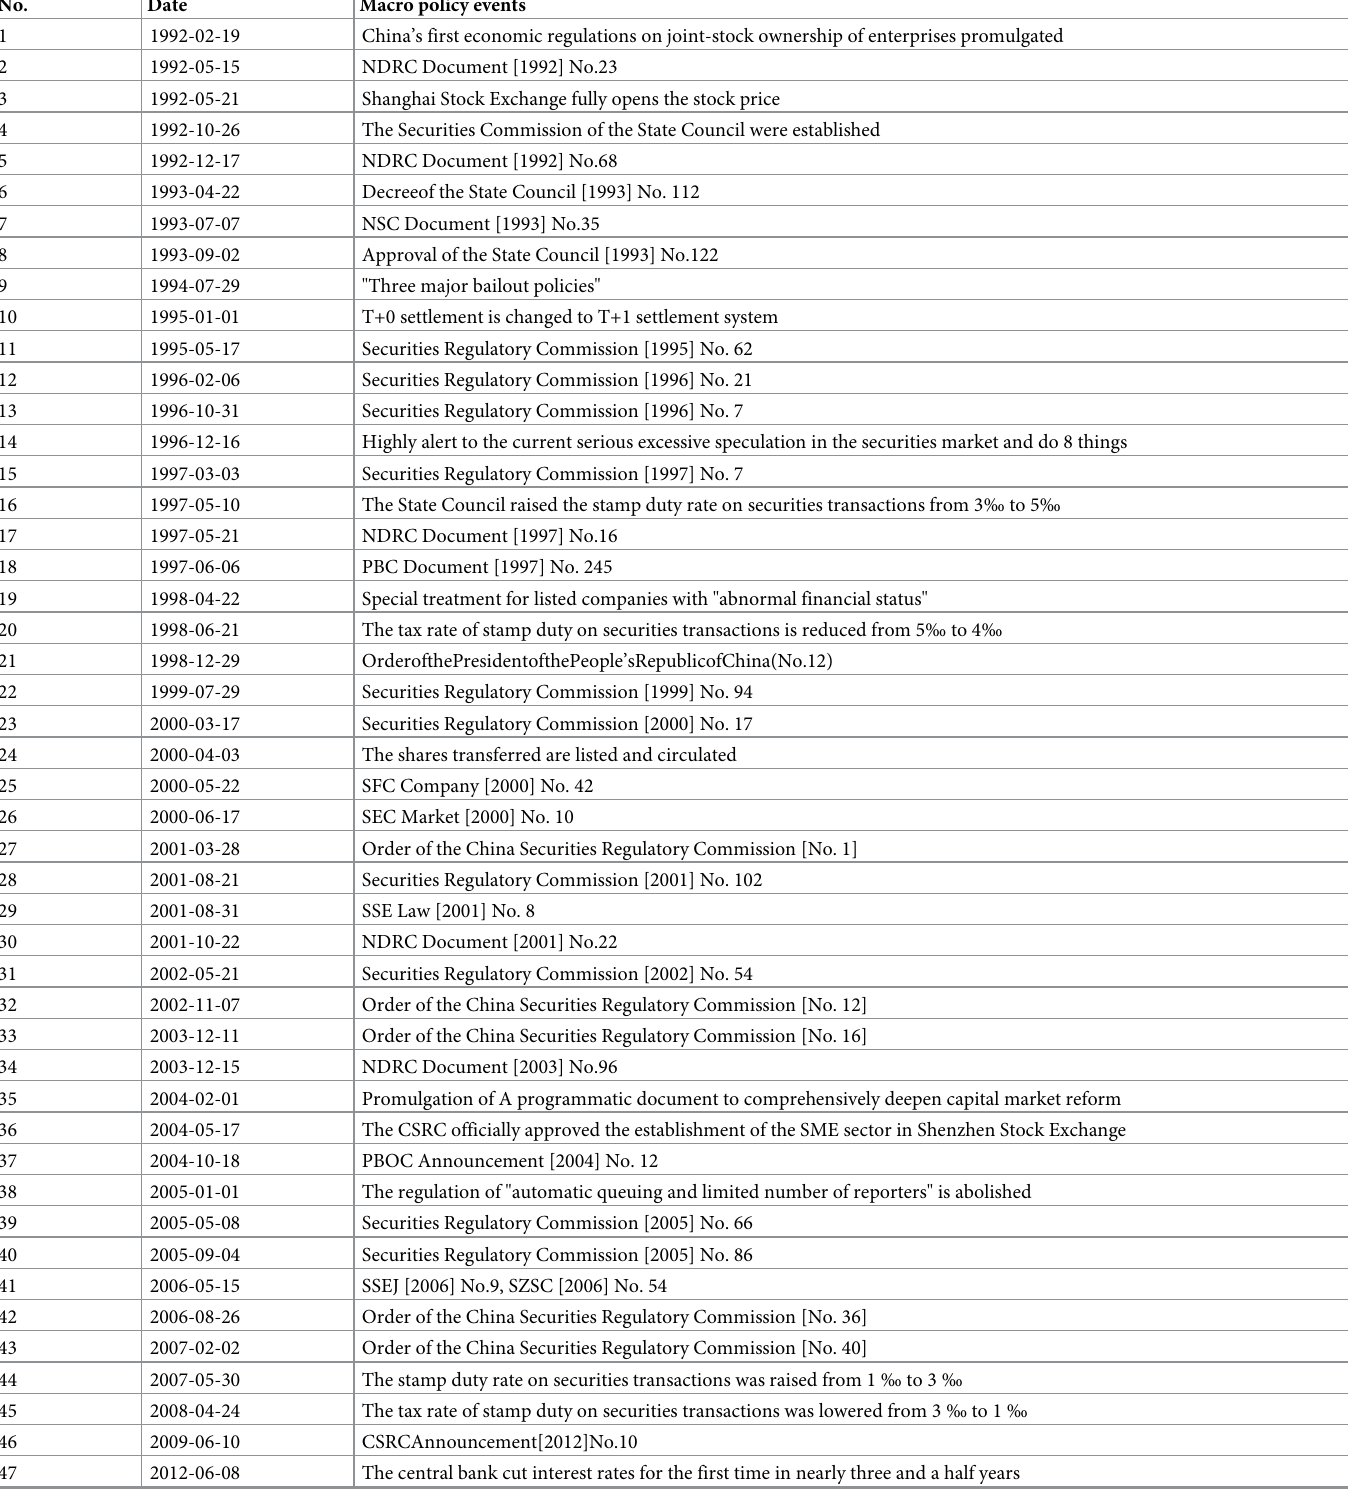
Table 1. Macro-policy information in China’s stock market